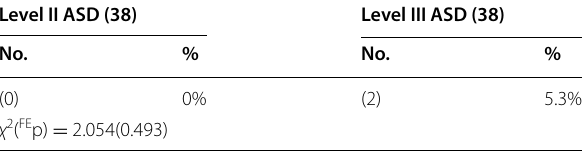
Data are expressed as a percentage